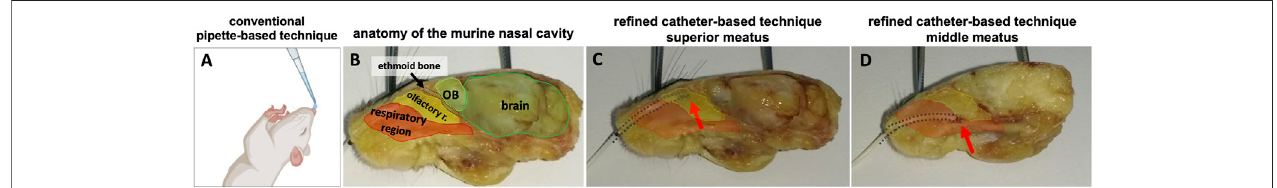
FIGURE 1 | Re fi ned catheter-based intranasal technique. (A) The sketch displays the conventional pipette-based technique to administer drops onto, or into, the nostril.Thismethodisunabletodiscriminatethenasalregionsandadditionallyholdsahighriskforswallowingandingestionofthedrugsolution. (B) Anatomyofasagittal section though a murine head showing the nasal cavity with the respiratory and the olfactory regions. The ethmoid bone separates the nasal cavity from the brain (for a better visibility the structure was encircled with a dotted line). Located caudally from the ethmoid bone are the olfactory bulbs (OB) that receive neuronal connectionsfromtheolfactorymucosathroughtheethmoidbone. (C) Therecentlydevelopedre fi nedtechniqueusesacatheterforneonatestoenterthenasalcavityvia thenostrils.Thecorrectangleforinsertionthroughthenostrilsisimportanttoreachtodorsalmeatusand,hence,toreachtheolfactoryregionwiththeethmoidturbinates (arrowhead). (D) A too low angle during insertion results in targeting the middle meatus (arrowhead). It is impossible to reach the olfactory region from here. Therefore, a suf fi cient training of the technique is required to target the olfactory region in alive animals. For a better visibility the catheter tip was encircled with a dotted line and the olfactory and respiratory regions were colored in (C) and (D) . Sketch (A) was created under license with